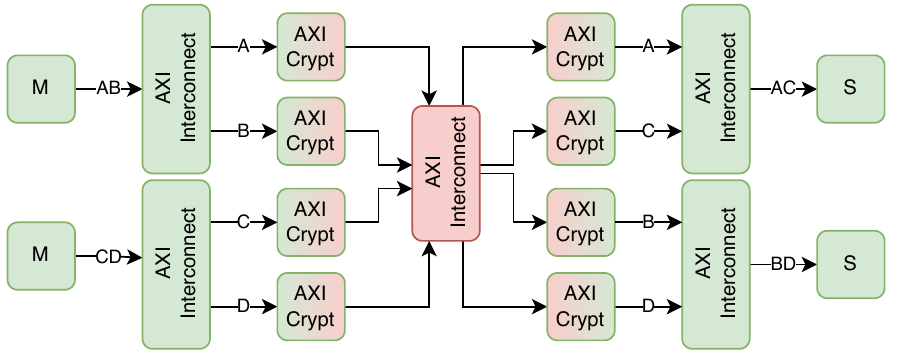
Figure 4. A multimaster–multislave environment. Any of the masters can access any of the slaves with a secured channel.